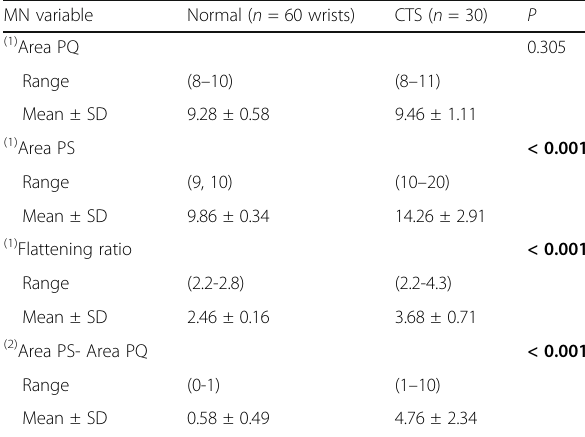
Table 1 Comparison between MN dimensions in normal individuals and CTS patients